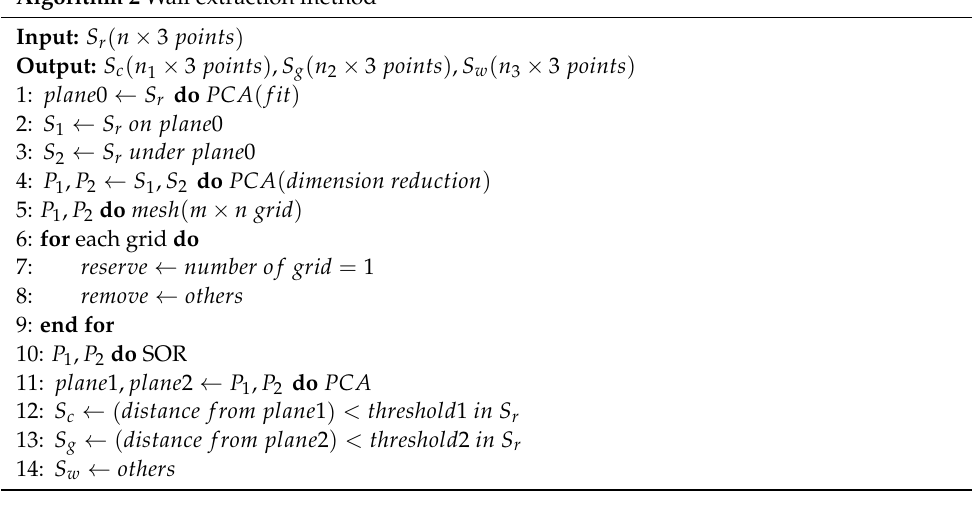
Algorithm 2 Wall extraction method